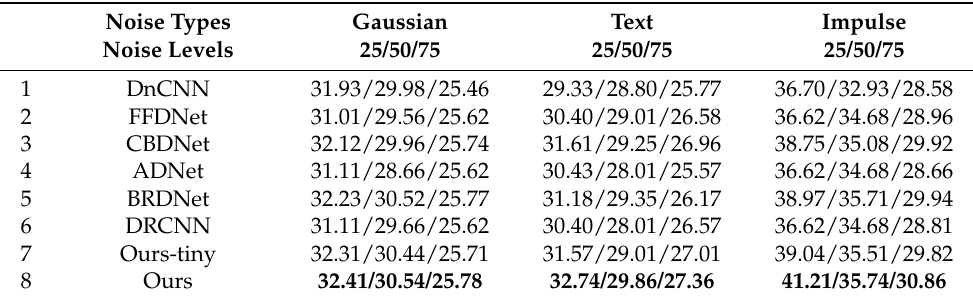
Table 5. Comparison of PSNR metrics of 6 latest CNN -based methods on the Kodak dataset. For each noise type, the highest PSNRs are marked in boldface.